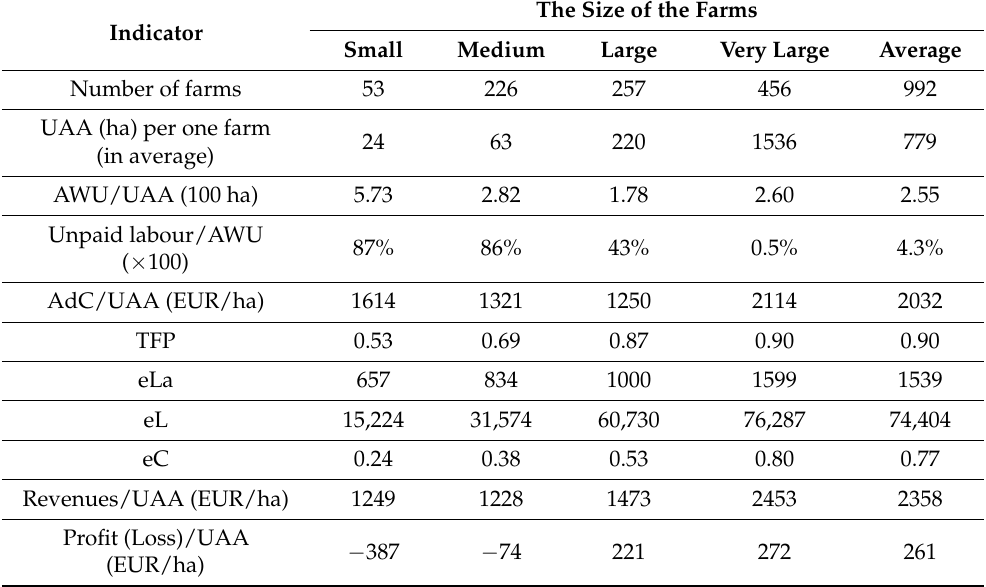
Table 3. Basic characteristics of farms and productivity indicators (2015–2020 average).